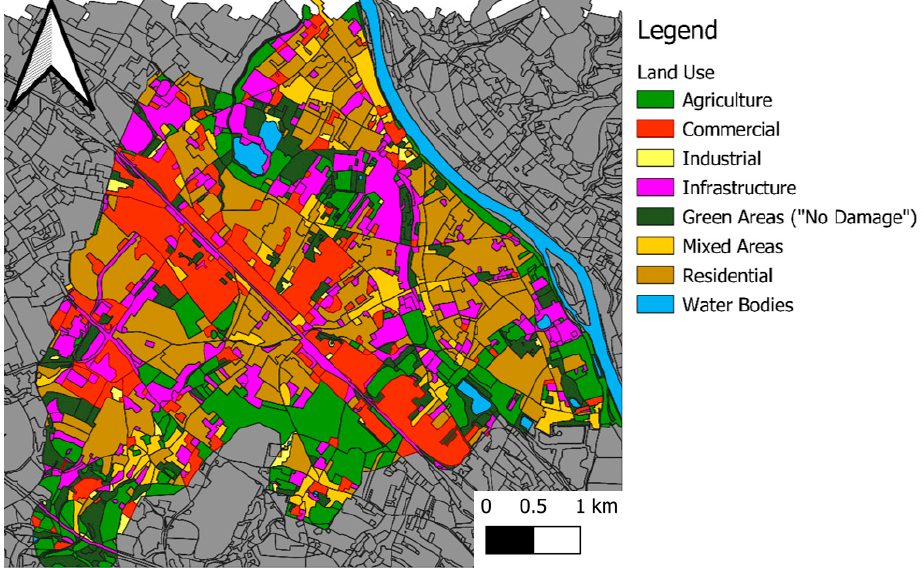
Figure 2. Land use and catchment of urban drainage subnetwork of the study area in Lockwitzbach